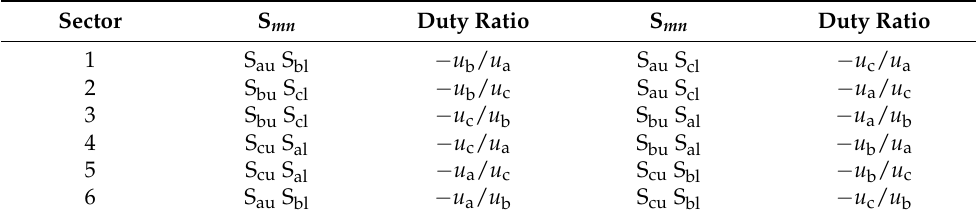
Table 1. Switch state on rectifier in each interval.